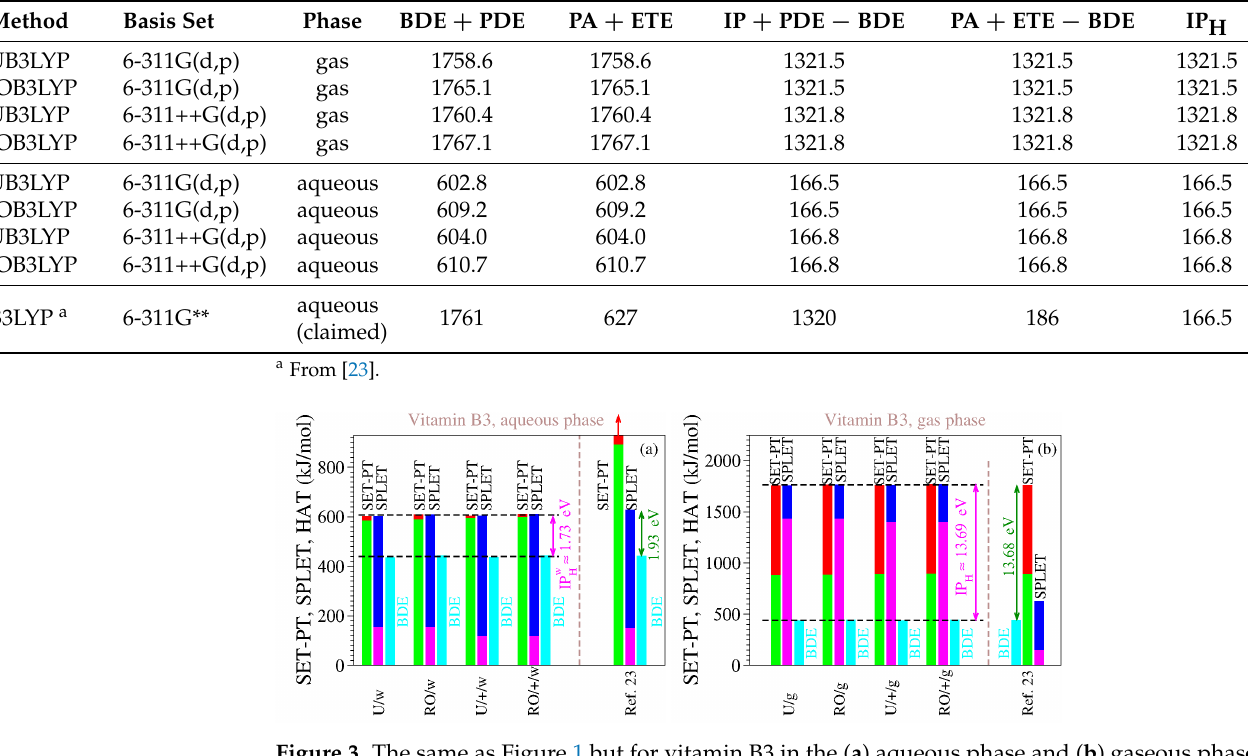
Figure 3. The same as Figure 1 but for vitamin B3 in the ( a ) aqueous phase and ( b ) gaseous phase. The numerical values underlying this figure are indicated in Tables 9 and